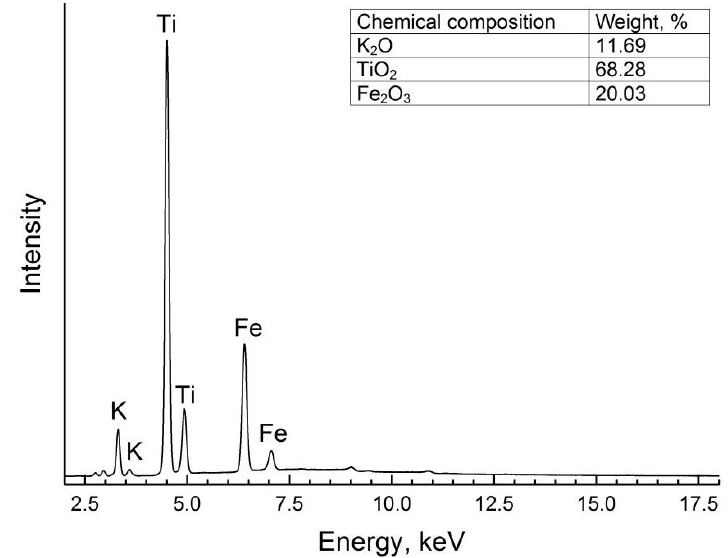
Figure 2. XRF spectrum of KFTO(H) powder.